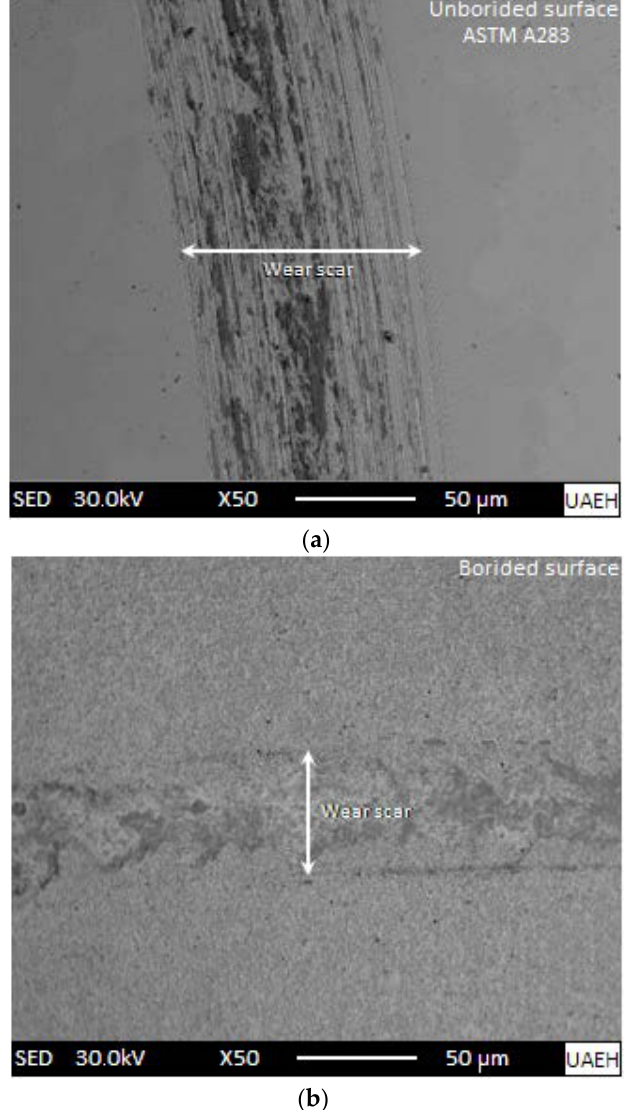
Figure 12. Wear tracks obtained on the surfaces of ( a ) untreated substrate and ( b ) boronized ASTM A283 steel for 8 h at 1273 K.